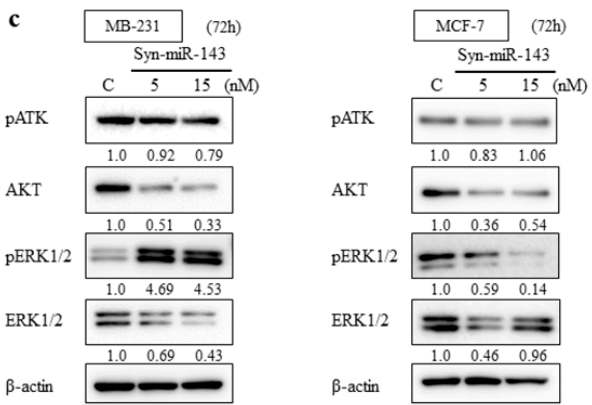
Figure 1. Overexpression of miR-143 in breast cancer cell lines, MB-231 and MCF-7. ( a ) Cell viability at 72 h after transfection of MB-231 and MCF-7 with control microRNA or synthetic miR-143 (syn-miR-143); ( b ) MB-231 and MCF-7 cells were transfected with control microRNA or syn-miR-143 and KRAS expression was detected by western blot; ( c ) The effector molecules of KRAS were detected by western blot. Results are presented with the mean ± SD; ** p < 0.01; *** p < 0.001.